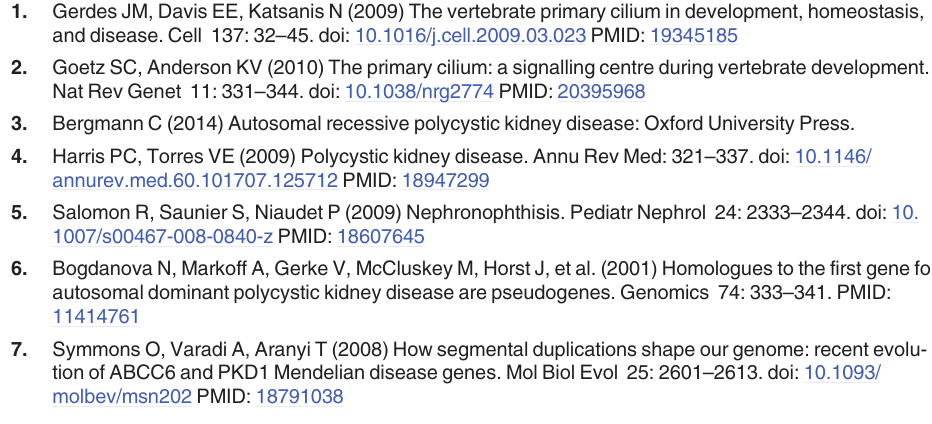
S3 Table. Coverage statistics of all target genes sequenced and analysed in parallel to